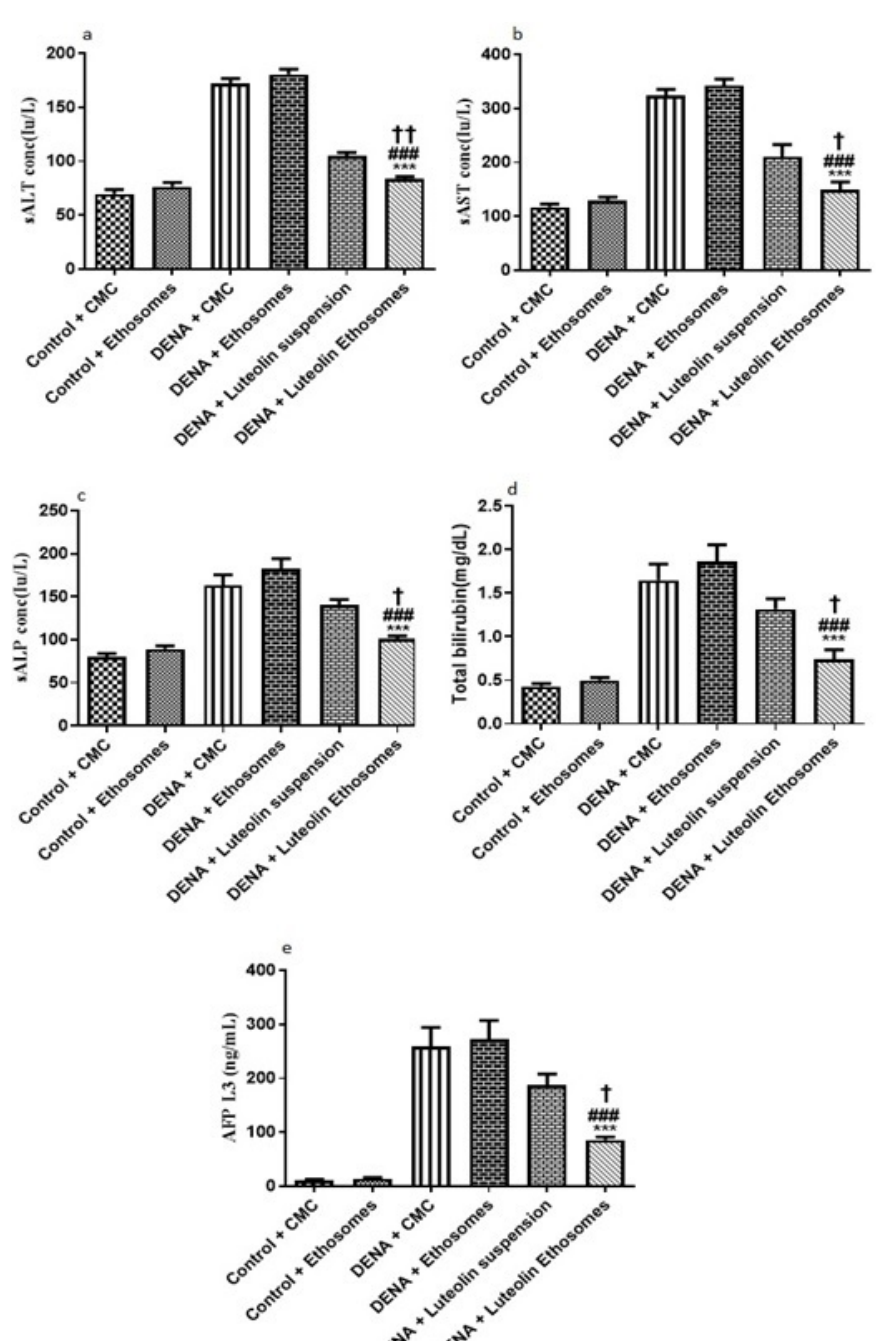
Figure 8. Effects of LUT and/or LUT-ENPs on ( a ) alanine transaminase (ALT), ( b ) aspartate transaminase (AST), ( c ) alkaline phosphatase (ALP), ( d ) total bilirubin, and ( e ) alpha fetoprotein-L3 (AFP-L3) Data are presented as mean ± SEM ( n = 12). *, #, and † indicate significant changes from control, DENA, and DENA+ Luteolin suspension groups respectively. † indicates significant change at p < 0.05; †† indicates significant change at p < 0.01; *** and ### indicate significant change at p < 0.001.